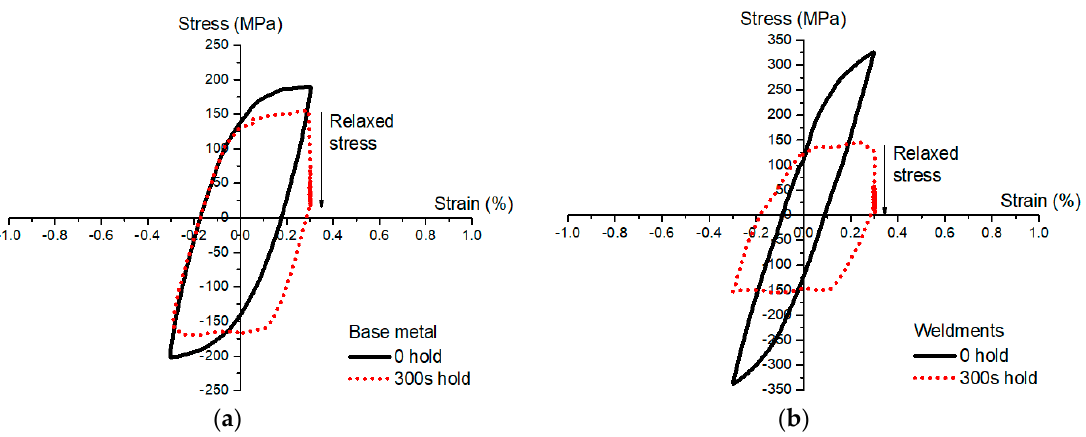
Figure 7. Hysteresis loops for low-cycle fatigue and creep-fatigue of Alloy 617: ( a ) Base metal; ( b ) Weldments.